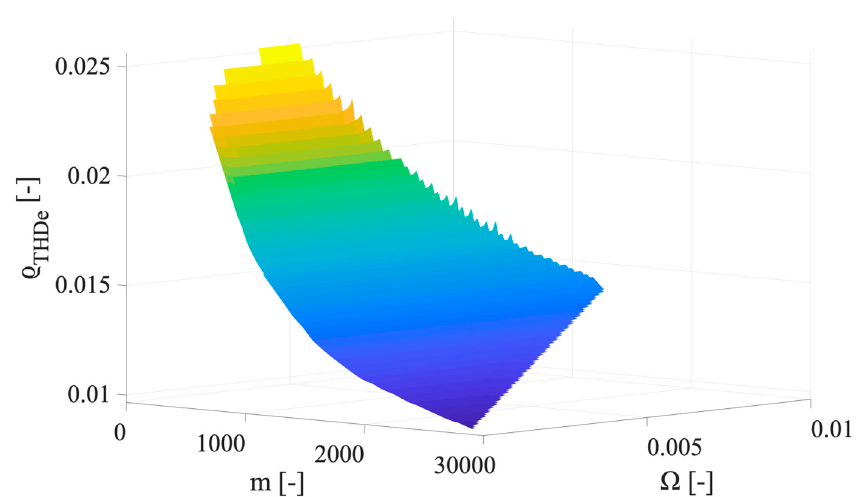
Figure 6. Graph of 𝜚 (cid:3021)(cid:3009)(cid:3005)_(cid:3032) values vs. 𝑚 and 𝛺 , for the accuracy class 0.5.